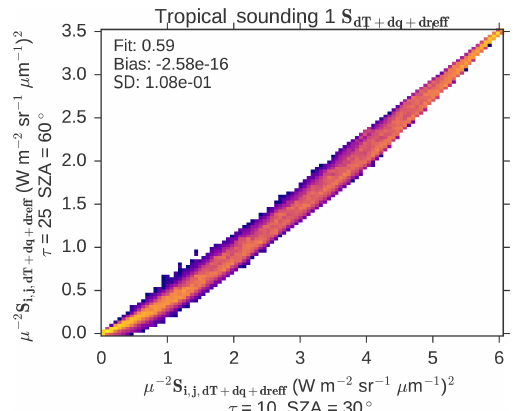
Figure 3. Two-dimensional histograms of covariance matrix ele- ments at 60 ◦ solar zenith angle as a function of the same values at 30 ◦ solar zenith angle for the mid-latitude meteorological state; = cos − 2 ( SZA ) to account for each value has been scaled by µ − 2 0 differences in illumination